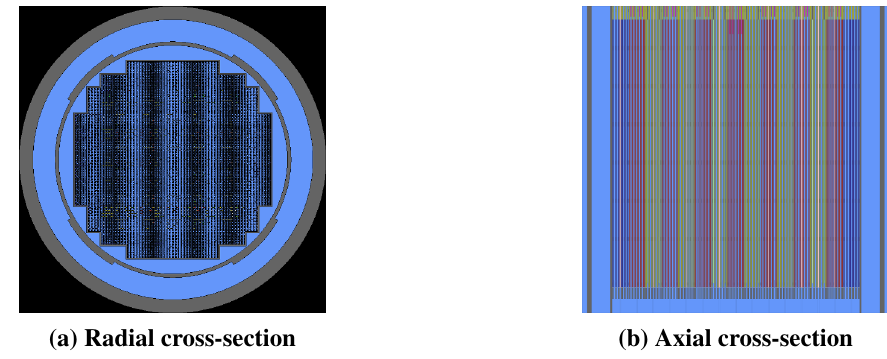
Figure 5: Radial (5a) and axial (5b )cross-sections of BEAVRS full core.